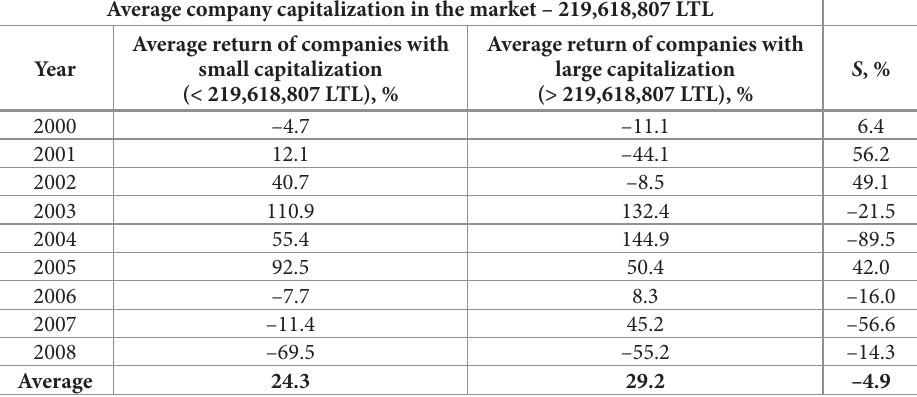
Table 3. Average company capitalization in the market on